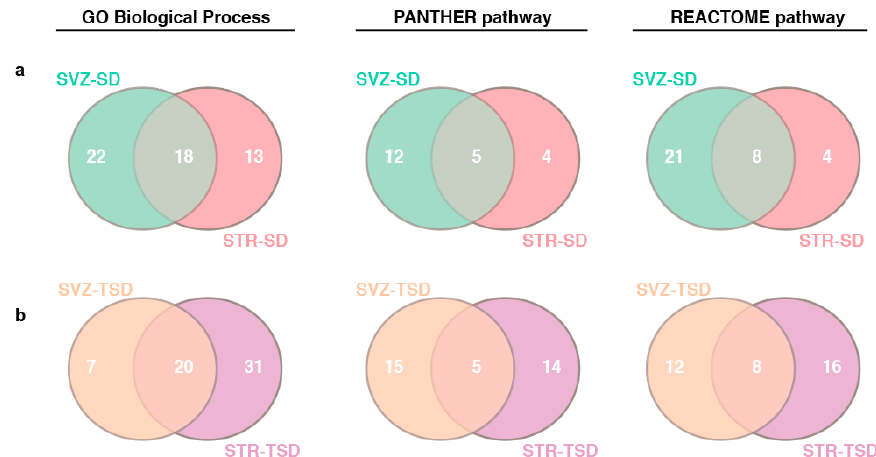
Figure 6. Venn diagram of GO BP and pathways enrichment in SVZ and STR of GM2 gangliosidosis. Shown are overlapping and non-overlapping biological process and pathways between ( a ) SD-SVZ and SD-STR; ( b ) TS-SVZ and TS-STR.